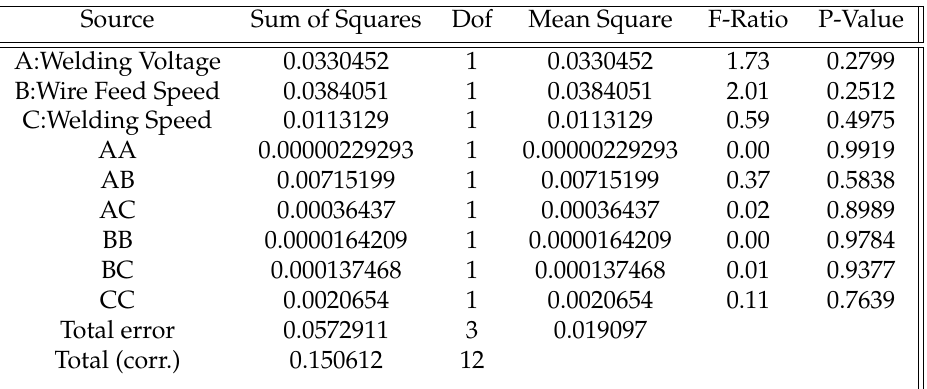
Table 5. Variance’s analysis for SQRT of Depth of Penetration